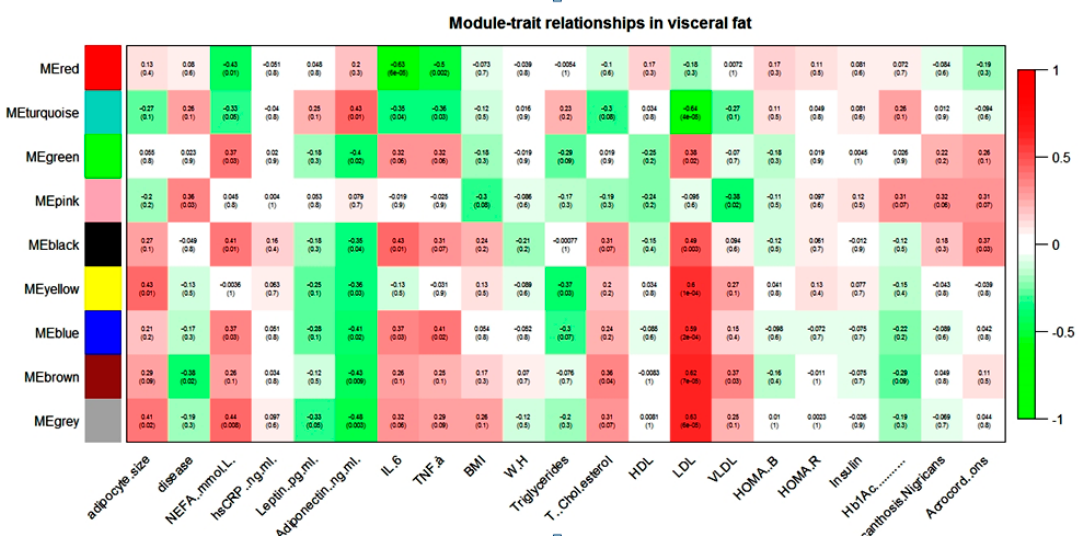
Figure 1. Module–trait relationship in visceral gene expression dataset.